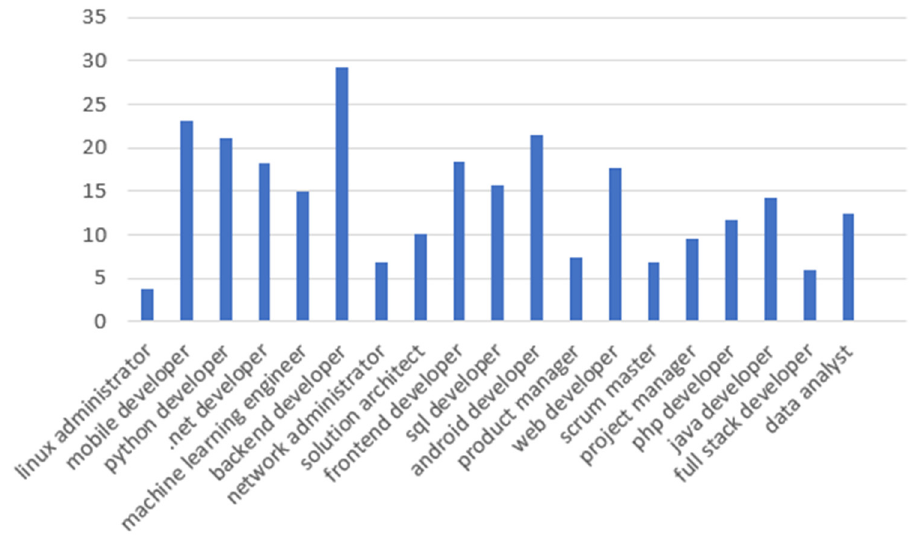
Figure 18. Success rate of finding job requirements in individual job positions—machine learning with marking of sentences between positive occurrences approach.